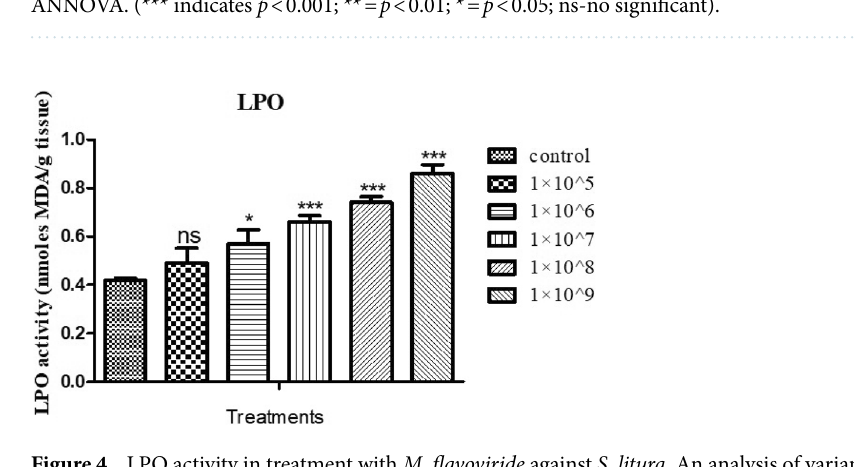
Figure 3. Phenoloxidase activity ( A ), CAT assay ( B ), SOD activity ( C ) and POX activity ( D ) after the treatment with M. flavoviride fungi spores against S. litura . An analysis of variance and multiple comparison test was performed with the data expressed as mean (± S.D) (significantly p * 0.05). Compared with control group by ANNOVA. (*** indicates p < 0.001; ** = p < 0.01; * = p < 0.05; ns-no significant).